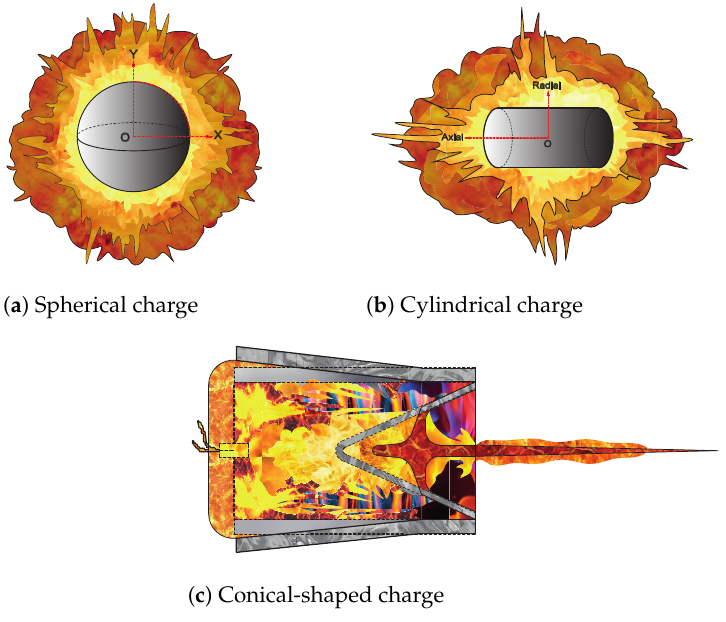
Figure 1. Sketch of shapes of shock wave